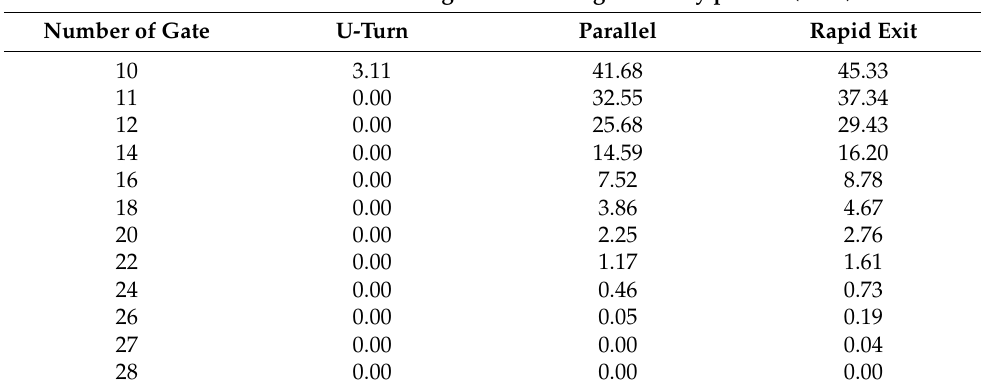
Table 11. Results of gate sensitivity analysis. Average Gate Waiting for Delay per AC (min.)